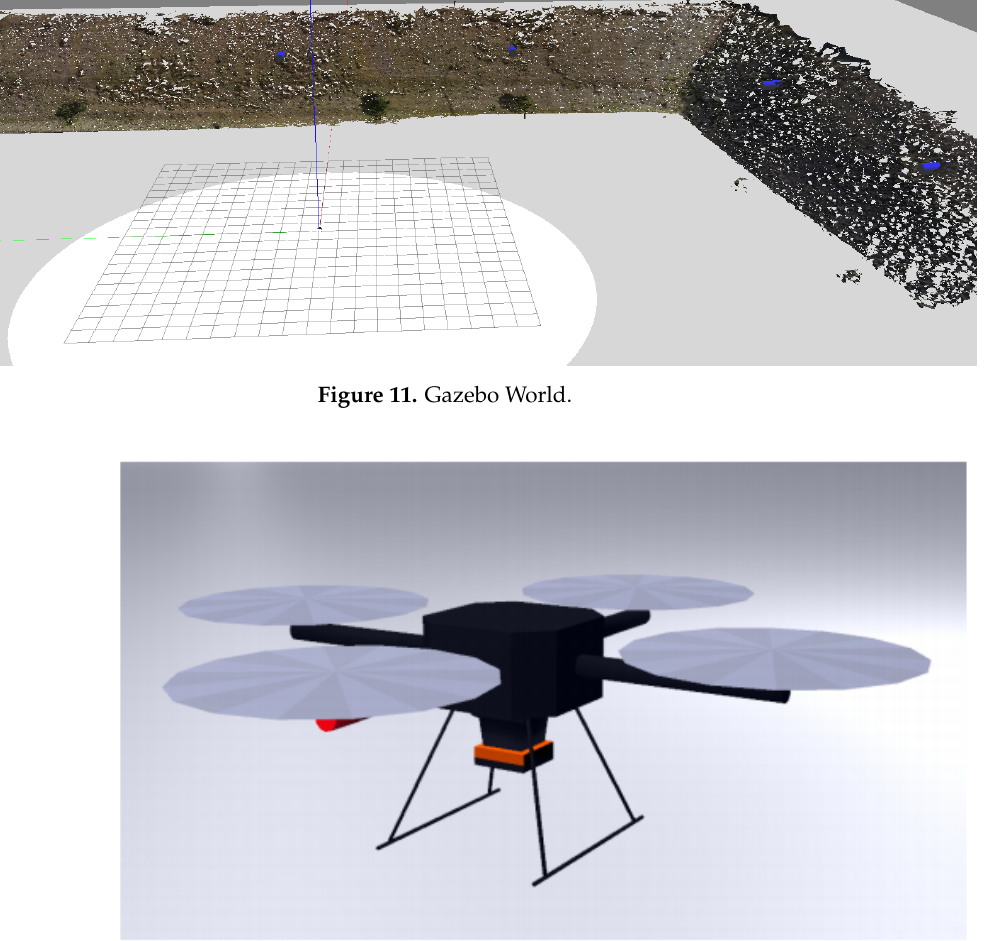
Figure 12. Hector_Quadrotor Model in Gazebo-ROS.